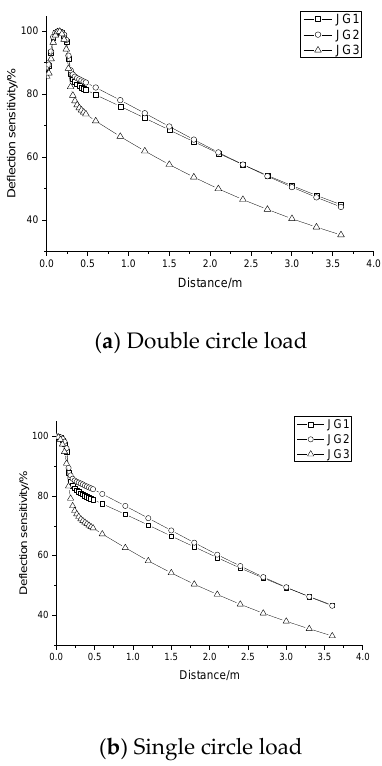
Figure 4. Deflection sensitivity of three structures.